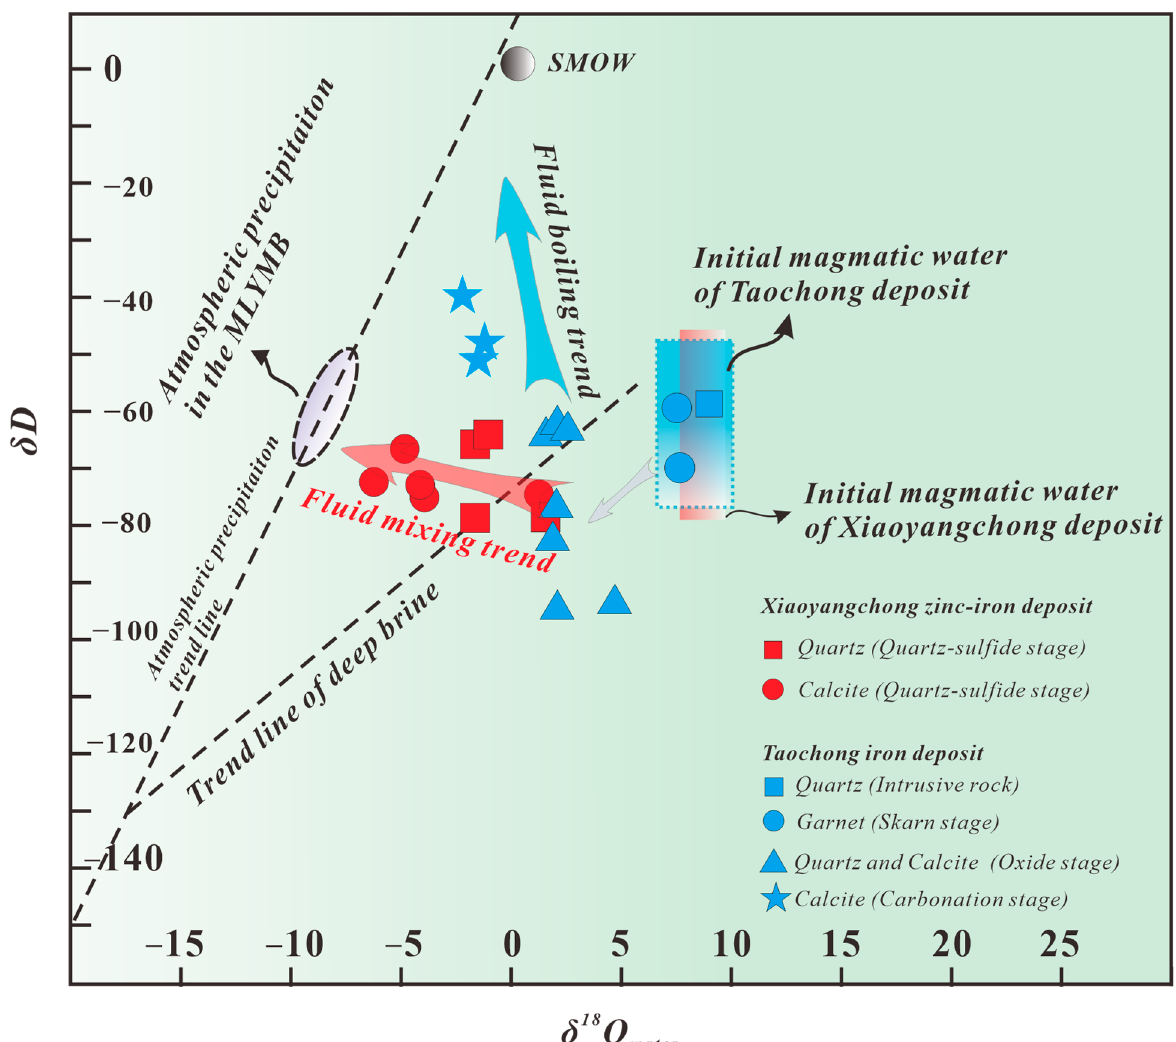
Figure 14. δ 18 O water vs. δ D plot of the isotopic composition of fluid inclusions in the typical deposits of the FVB. Data sources (see Supplement Table S6): Data of the Xiaoyanghcong and Taochong deposits are from [80,81]; range of Mesozoic meteoric water in the MLYMB is from [168,169]; fluid boiling trend is from [170].